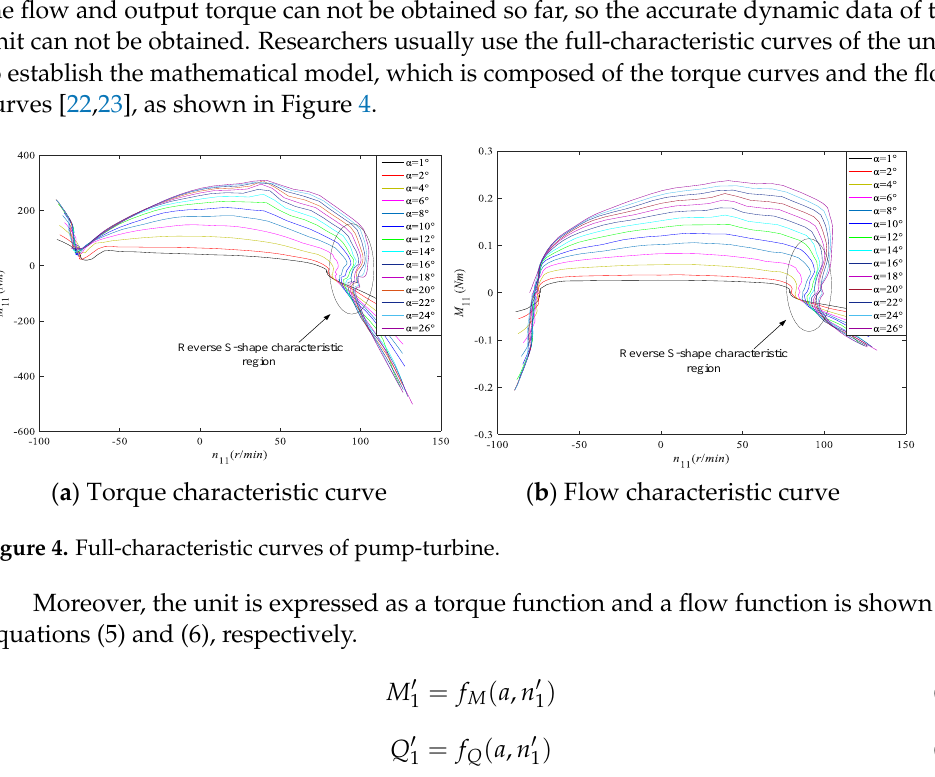
Figure 3. Schematic diagram of the characteristic line method.